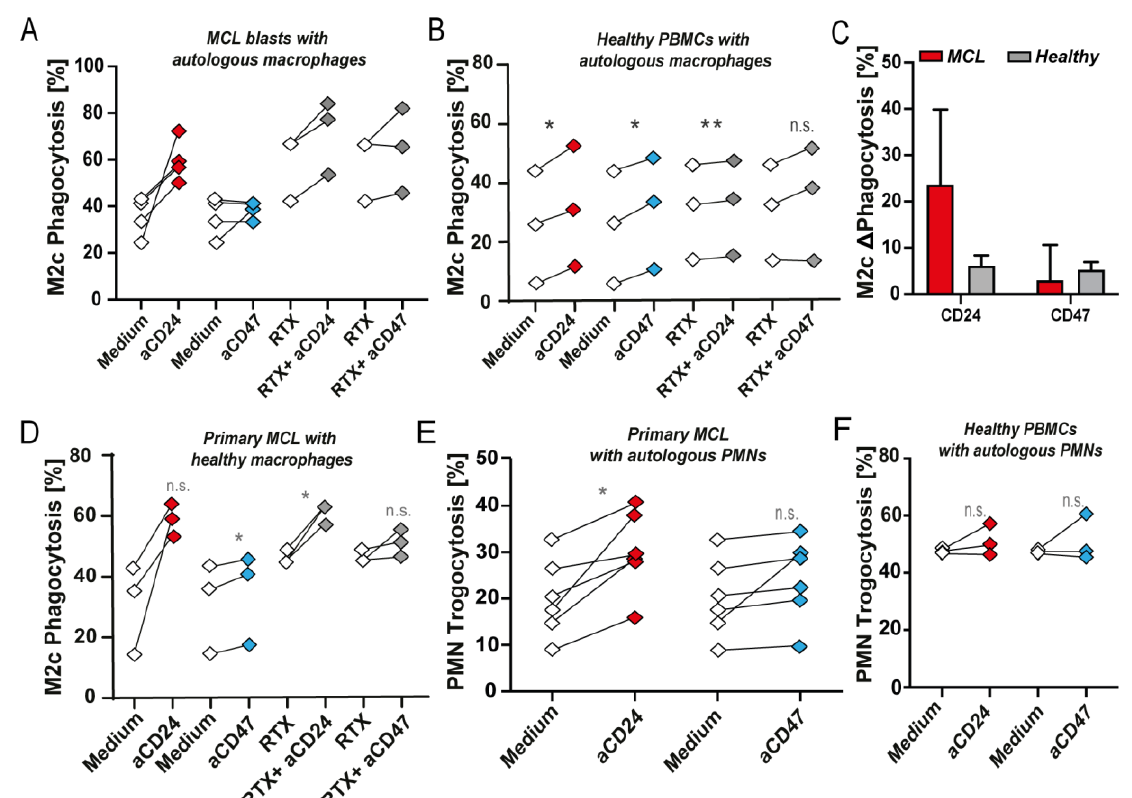
Figure 3. CD24 and CD47 antibody-mediated phagocytosis of MCL and healthy blasts by primary patient-derived autologous and allogeneic healthy donor macrophages. ( A ) Phagocytosis of MCL blasts by autologous macrophages upon CD24 mAb SN3 or CD47 mAb InhibRx treatment ( n = 4) and combination treatment with RTX ( n = 3). ( B ) Phagocytosis of healthy PBMCs by autologous macrophages upon CD24 mAb SN3 or CD47 mAb InhibRx treatment and in combination with RTX. ( n = 3). ( C ) Comparison between phagocytosis levels induced upon CD24 and CD47 antibody treatment of MCL blasts (red) and healthy PBMCs (gray). ( D ) Phagocytosis of MCL blasts co-cultured with macrophages from healthy donors upon treatment with CD24 mAb SN3 or CD47 mAb InhibRx and in combination with RTX. ( n = 3). ( E ) Trogocytosis of MCL blasts by autologous PMNs upon treatment with CD24 mAb SN3 or CD47 mAb InhibRx ( n = 5). Statistical testing was performed using paired Student’s t -test. ( F ) Trogocytosis of healthy PBMCs by autologous PMNs upon treatment with CD24 mAb SN3 or CD47 mAb InhibRx ( n = 3). Statistical testing was performed using paired Student’s t -test. Where indicated, n.s. = non-signfiicant, * = p < 0.05; ** = p < 0.01.